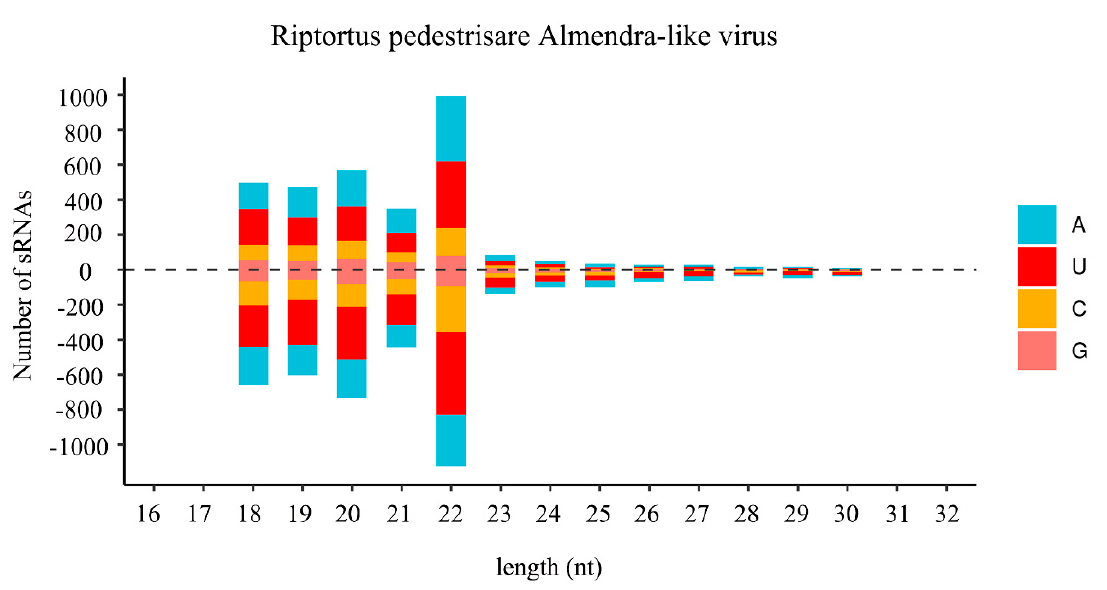
Figure 3. Profile of virus-derived small interfering RNAs (vsiRNAs) of Riptortus pedestris almendra-like virus (RiALv). Positive and negative values indicate that the vsiRNA was derived from the positive- and negative-sense strands. Color coding shows different nucleotides, and the corresponding names are list on the right.